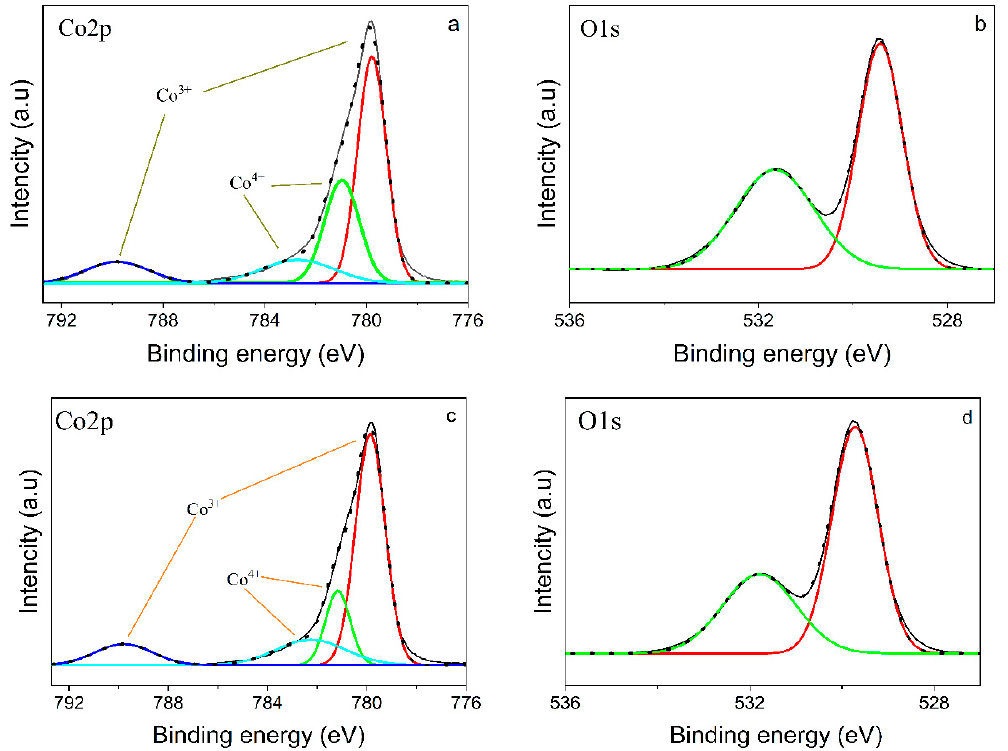
Figure 3. XPS spectrum of Co2p and O1s of thin film annealed ( a , b ) at 550 °C for 1 h 20 min in Ar; ( c , d ) at 650 °C for 1 h 20 min in Ar. ( c , d ) at 650 ◦ C for 1 h 20 min in